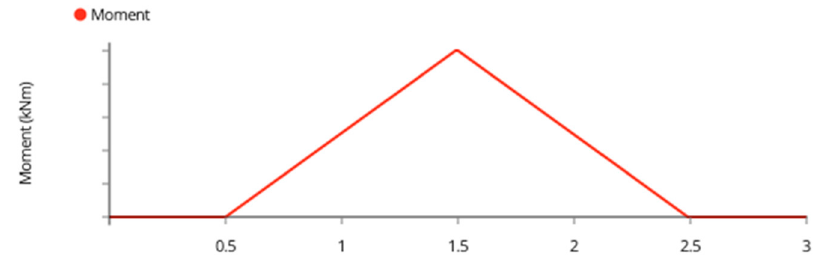
Figure A15. Bottom beam bending force diagram. The deflection diagram is shown in Figure A16.